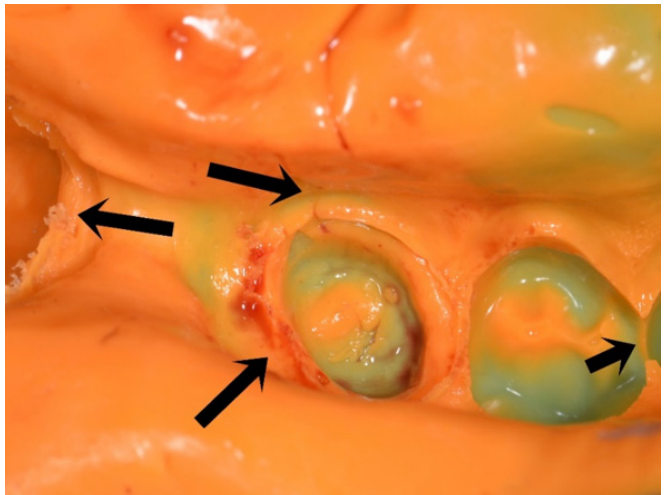
Figure 1. Premolar region of a double mixing impression for a fixed dental prosthesis made from a light-body (orange) and heavy-body (green) polyvinylsiloxane elastomer. The left and right arrow mark ruptures that suffered a loss of material. The top arrow shows a throw of material forming a cleft that intersects the finishing line of the preparation due to an incomplete merging of the material. The lower arrow points at surface changes due to moisture/ blood interaction.